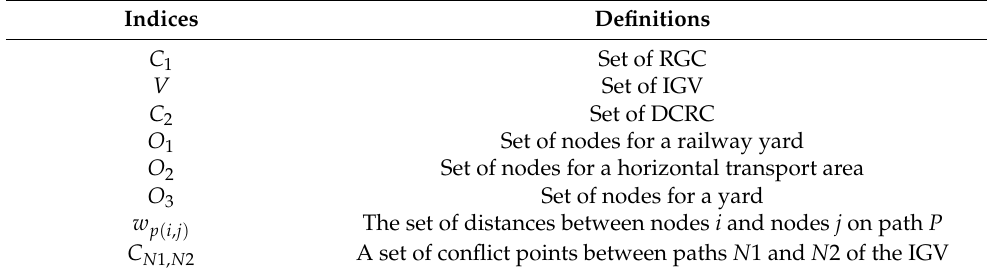
Table 1. Indices for the model formulation.